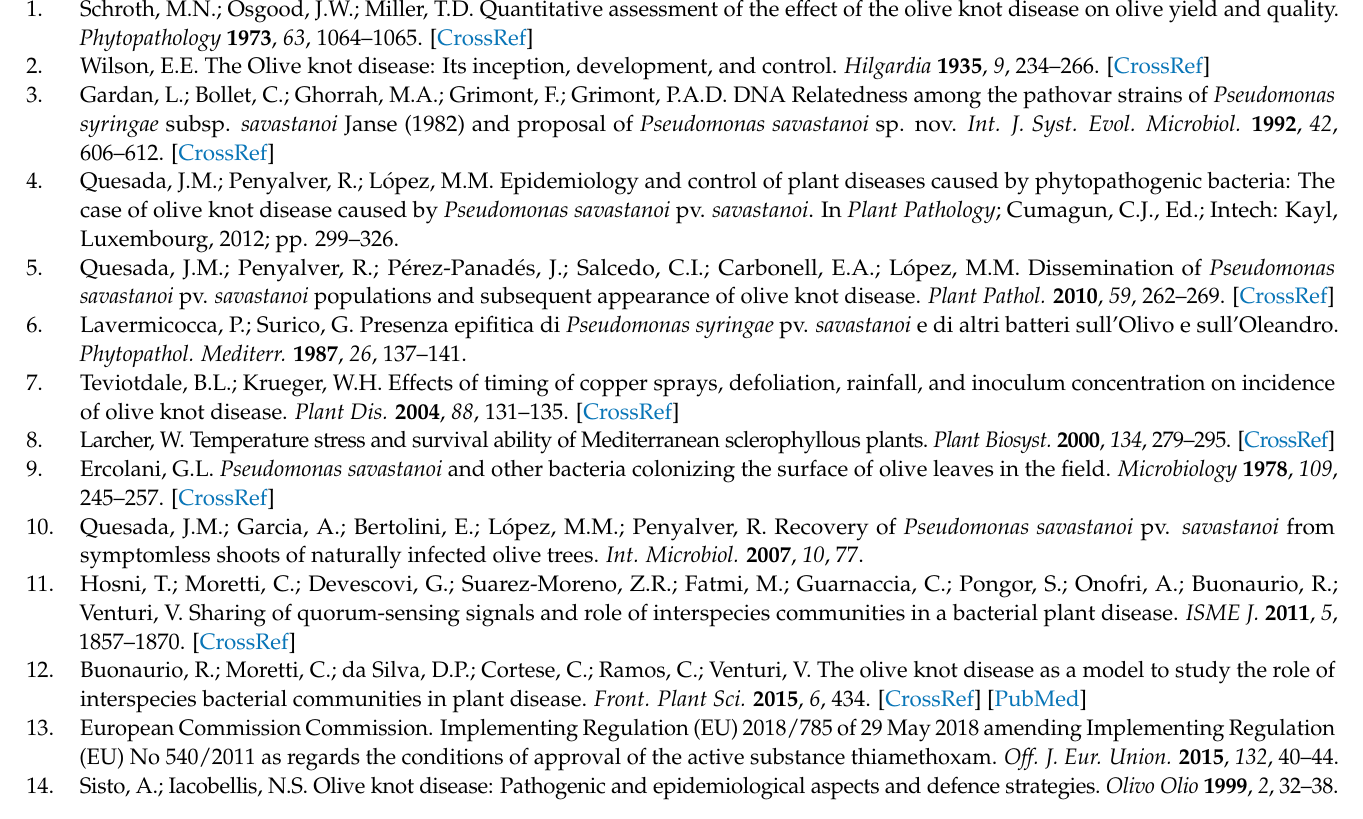
(A) and fungal communities (B). Table S1: Differential abundance of the bacterial OTUs between